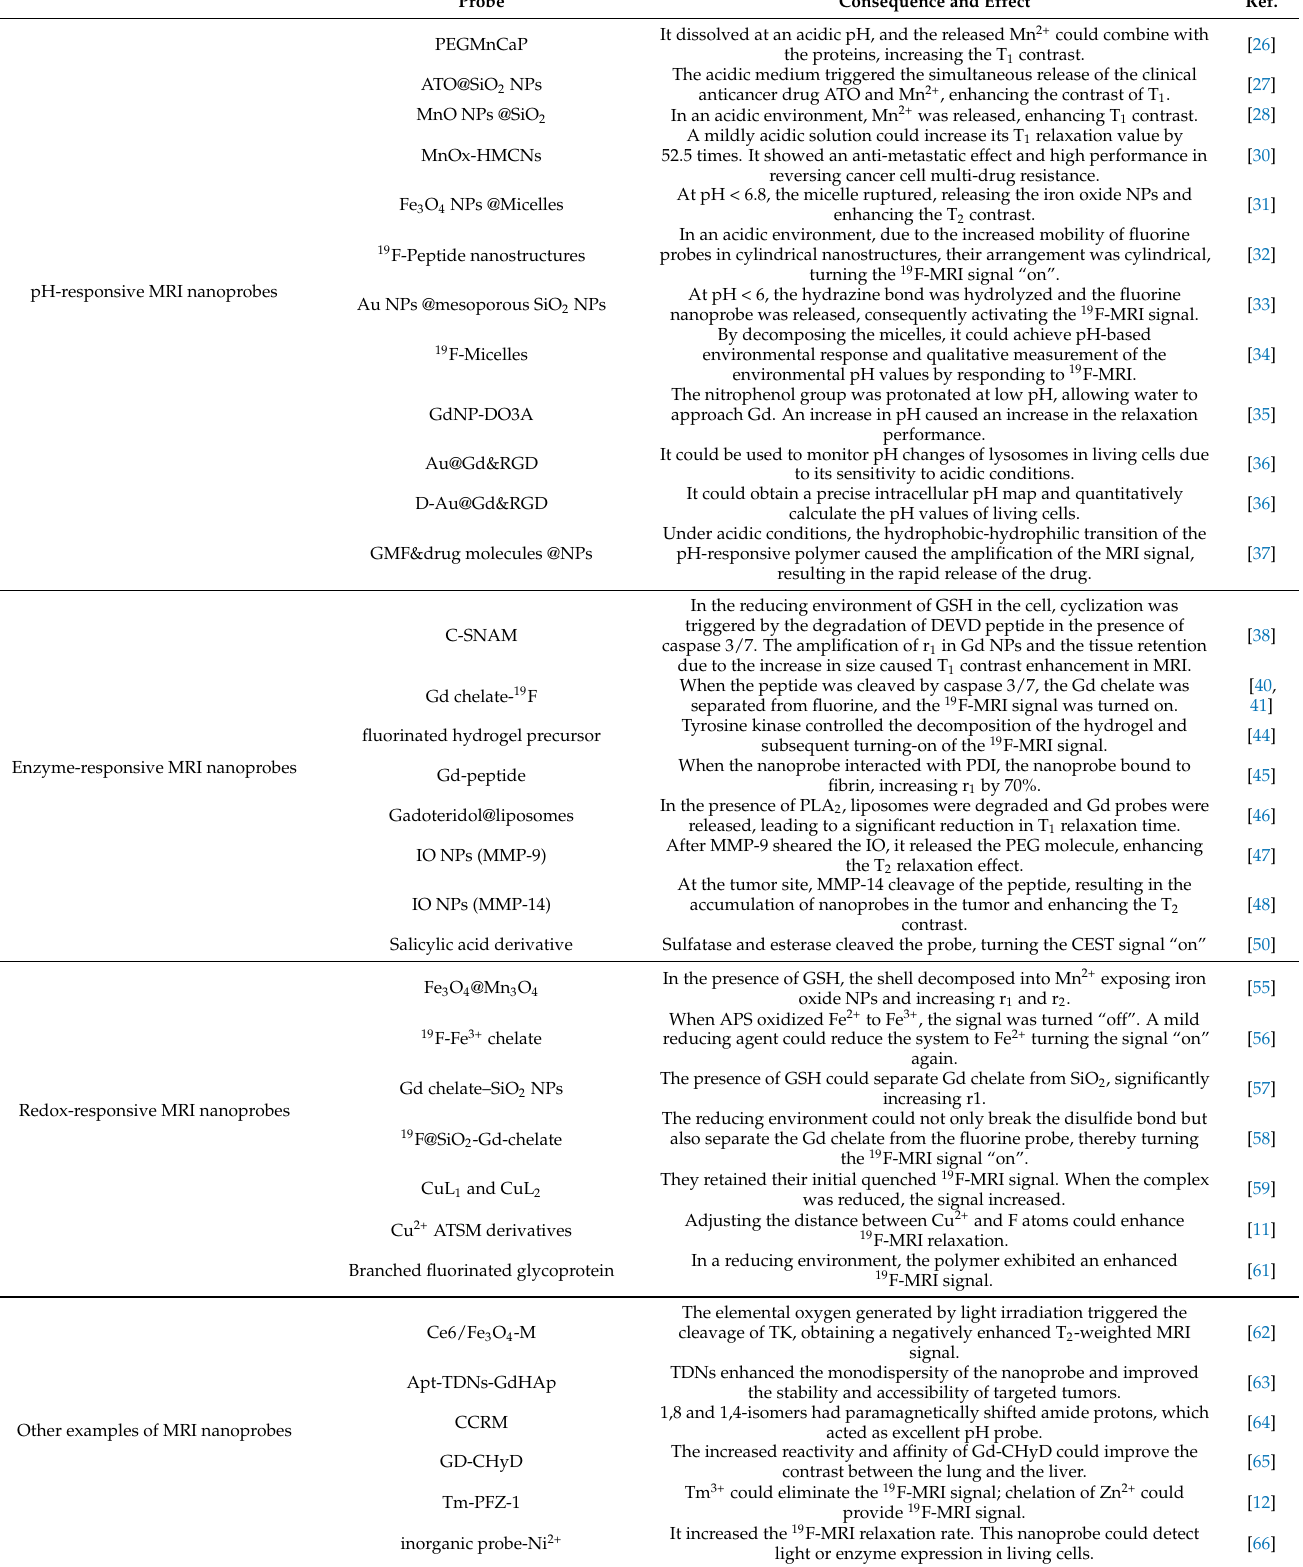
Table 1. Summary of the design of environment-responsive MRI